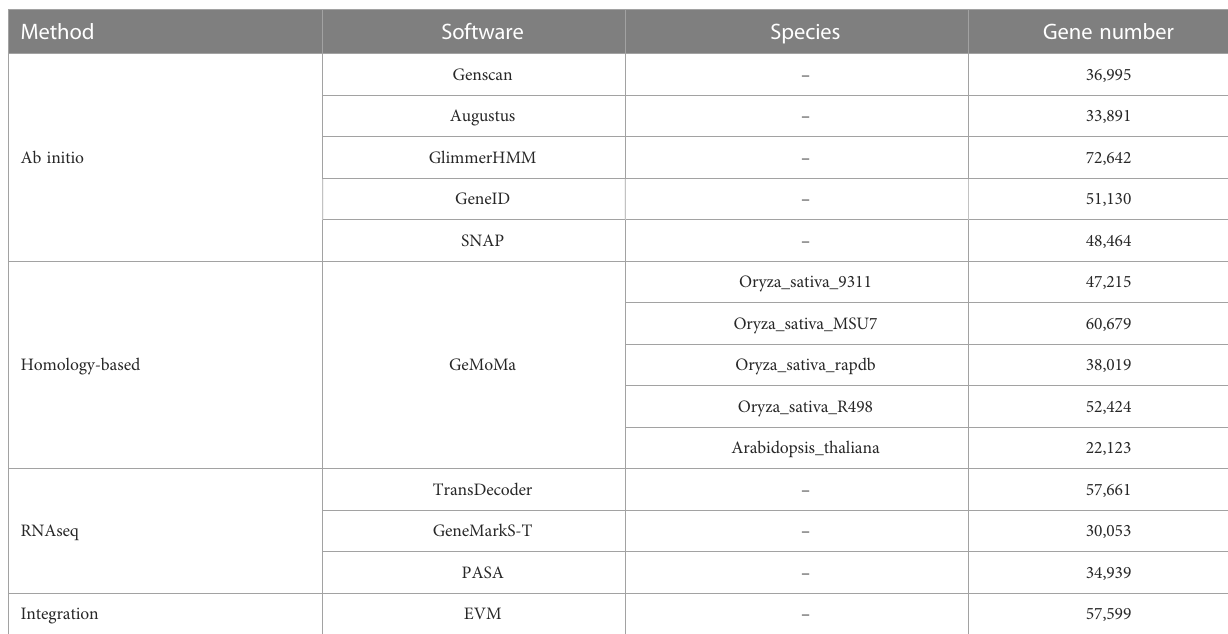
TABLE 4 The statistics information of the predicted genes.